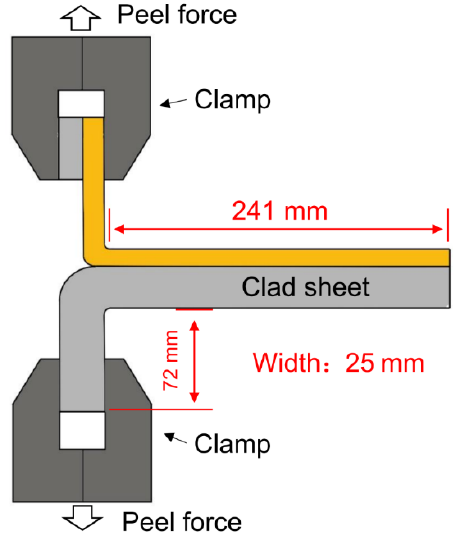
Figure 2. Test specimen and method of peel testing the clad sheets.